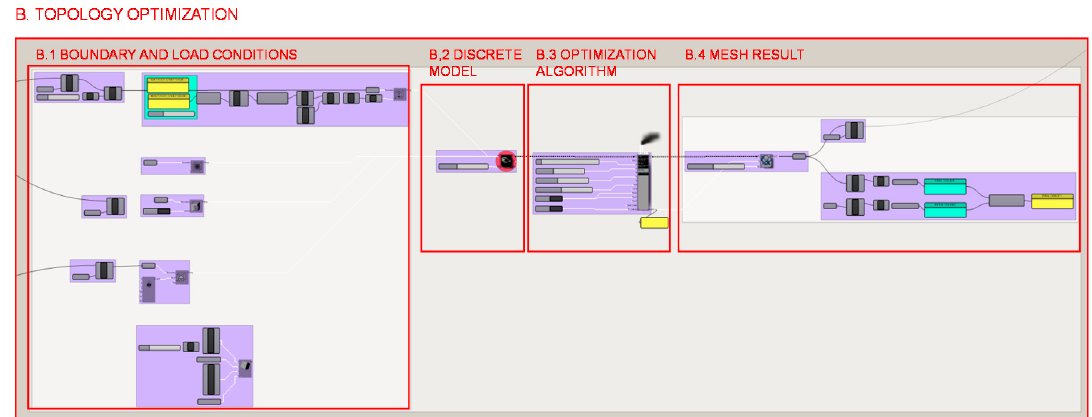
Figure 18. Programming structure definition developed for the topology optimization of the heel.